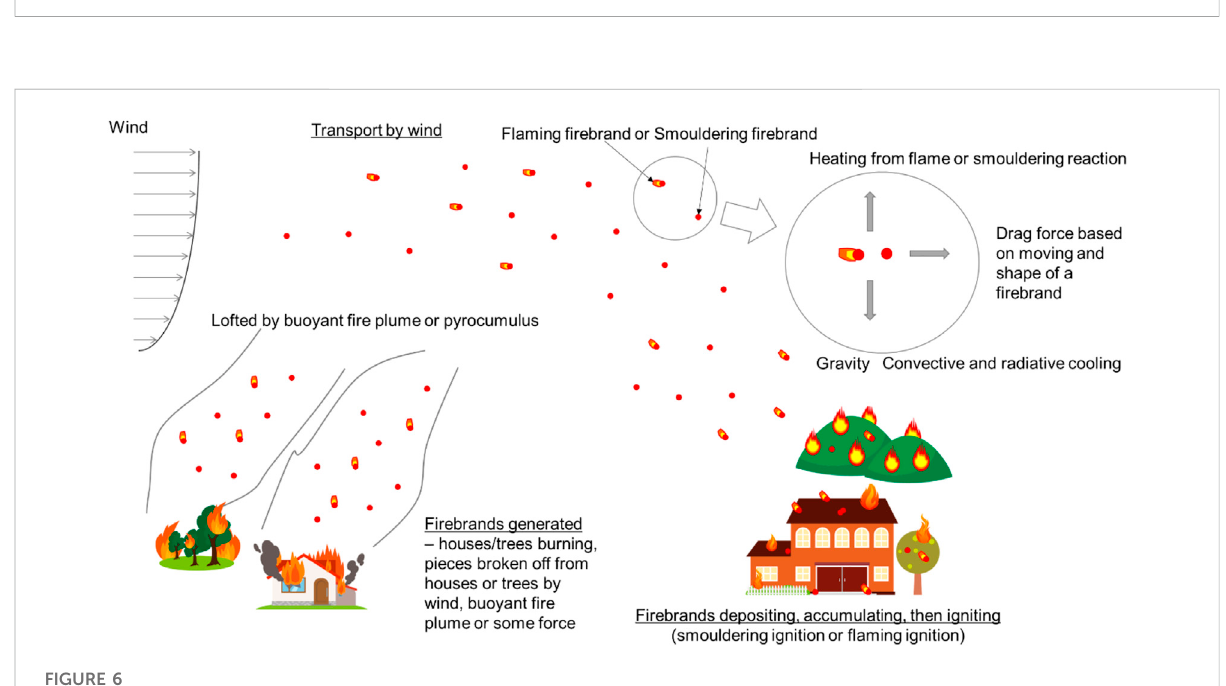
FIGURE 6 Schematic of fi rebrand